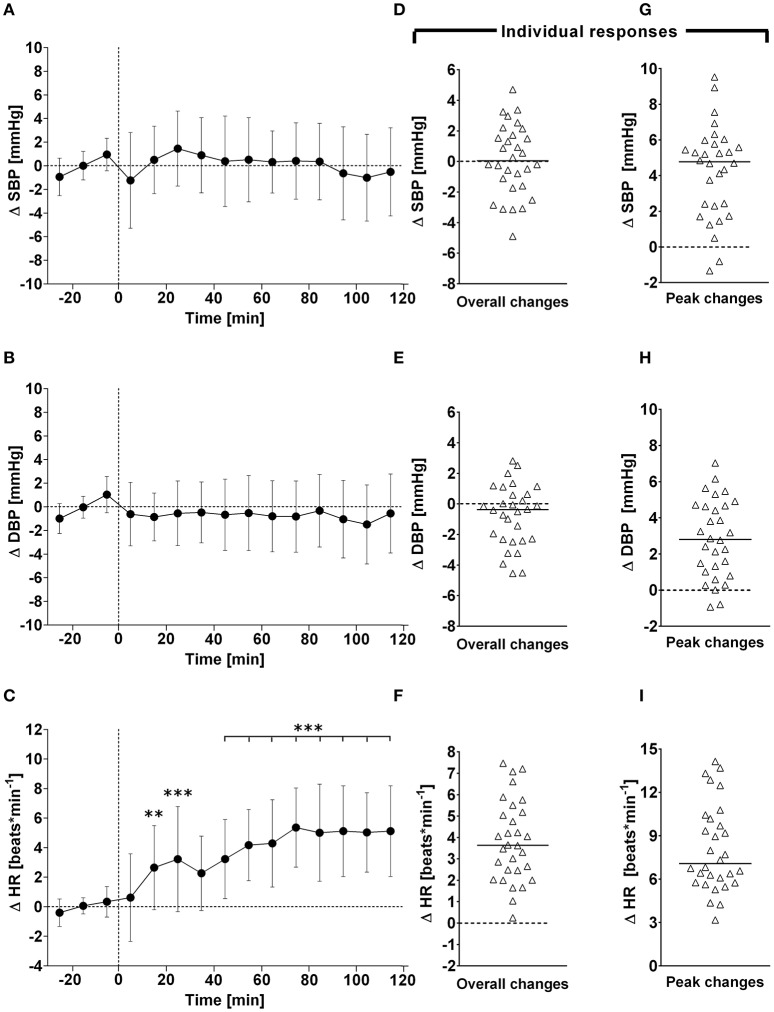
(A–C): Time course of changes (Δ) from baseline in systolic blood pressure (SBP), diastolic blood pressure (DBP), and heart rate (HR), respectively. Closed circles (•) represent averaged beat-to-beat data over 10 min intervals, which were subtracted from each baseline level and presented as deltas. Data recorded during the 4 min glucose ingestion period were excluded from the analysis, and Time 0 denotes the resumption of continuous cardiovascular measurements after subjects have finished the oral glucose drink. (D–F) represent overall (i.e., averages over 120 min with baseline values subtracted) changes in SBP, DBP, and HR relative to baseline. (G–I) represent peak (i.e., derived from the maximum response averaged over a 10 min interval) changes in SBP, DBP, and HR relative to baseline. **P < 0.01 and ***P < 0.005 represent statistically significant differences over time from baseline values (left). values are reported as means ± SD, whilst right data are presented as a scatter dot plot with a median (bold horizontal dashed line).